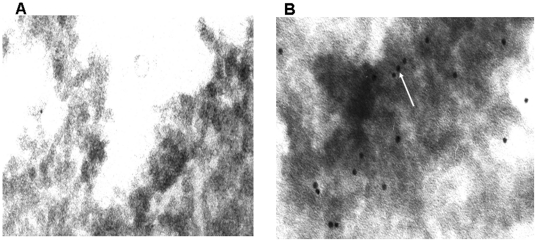
Localization of C-RP in human adipocytes using Immunoelectron microscopy.Panel A served as a negative control and this slide was not incubated with primary monoclonal antibody (Mab) against human CRP, but with IgG isotype. Panel B slide was labeled with Mab against human CRP and bound antibodies were displayed with coupled goat anti-mouse 15 nm gold particles. White arrow shows one CRP gold-stained particle (Black dot).